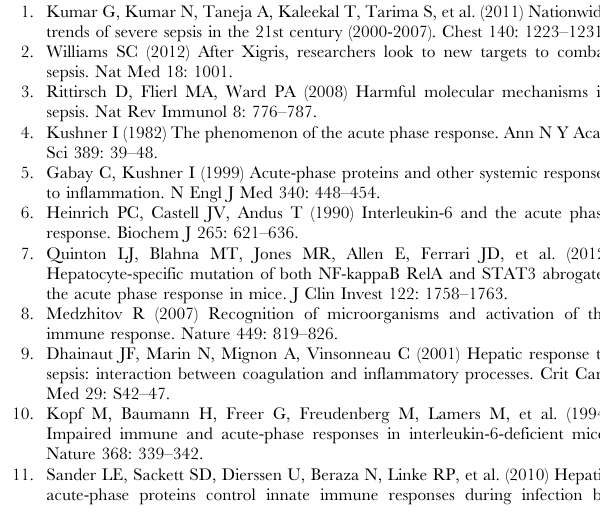
(TIF) Figure S4 Zn/pyrithione inhibits STAT3 signaling at early time points after IL-1/IL-6 treatment in HepG2 cells. The densitometry analysis is shown on the right (Two-way ANOVA with Bonferroni post hoc, * p , 0.05). (TIF) Figure S5 A proposed working model illustrates how Zn deficiency impacts JAK-STAT3 and NF- k B pathway, resulting in augmentation of SAA1 production. Zn deficiency increases STAT3 activation, possibly through ROS and SHP1 modulation, leading to increased SAA1 production. SAA1 then possibly activates monocytes and other immune cells, thereby perpetuating a dysfunctional amplification loop leading to an exaggerated inflammatory response and injury. (TIF)